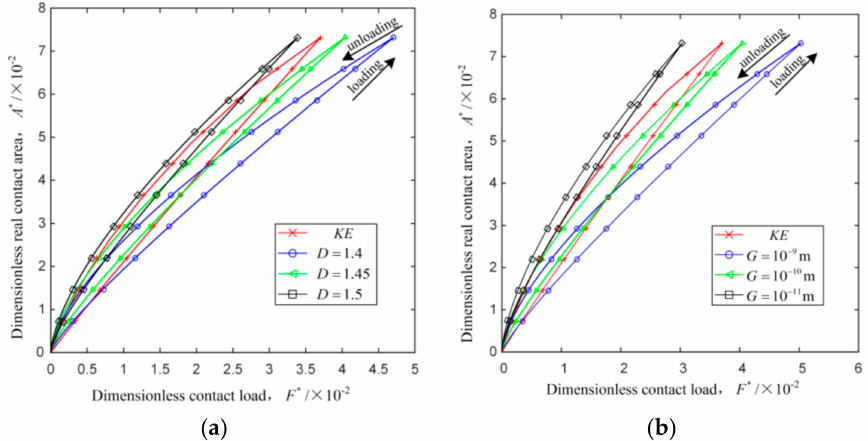
Figure 8. The comparison between the present model and KE statistical model. ( a ) G = 10 − 10 m, 1.4 ≤ D ≤ 1.5; ( b ) D = 1.45, 10 − 11 m ≤ G ≤ 10 − 9